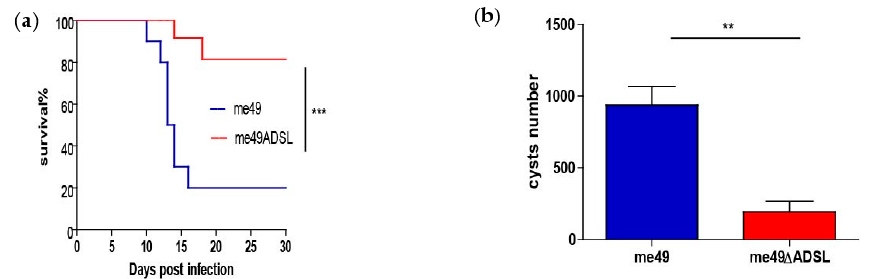
Figure 2. Virulence and cyst formation of the Δ ADSL mutant in mice. ( a ) Virulence assessment of